Question: Briefly state, in one sentence, what is plotted here.
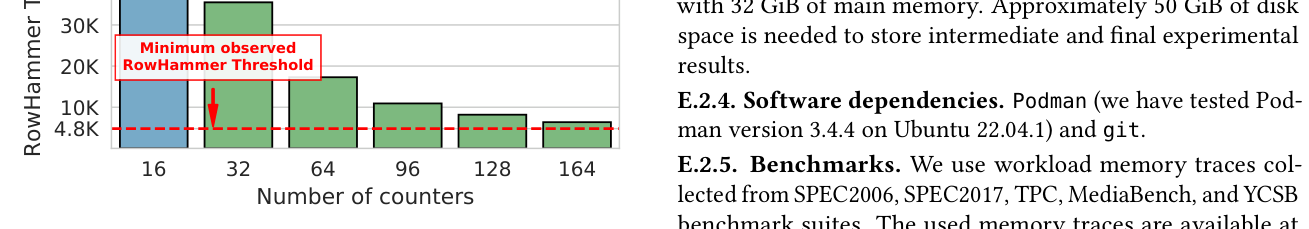
Answer: shows the maximum aggressor row activation counts (y-axis) that the access pattern achieves when the DRAM chip employs the reverse engineered TRR mechanism as is (the blue leftmost bar) and the chip employs future versions of the TRR mechanism that implement more aggressor row activa- tion counters (green bars toward right), where we depict the number of activation counters on the x-axis.